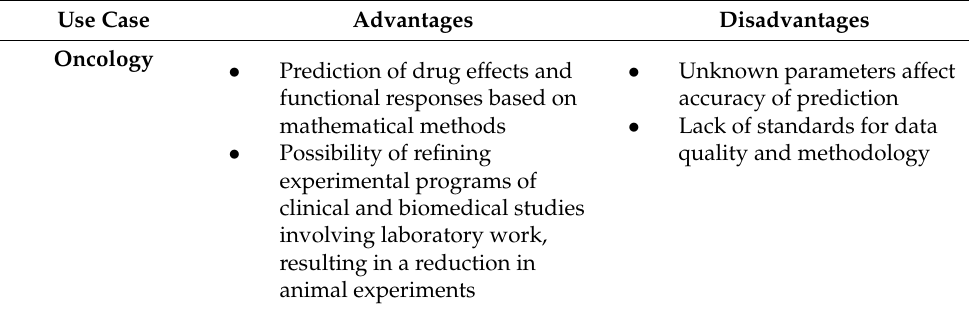
Table 3. In silico models for personalized